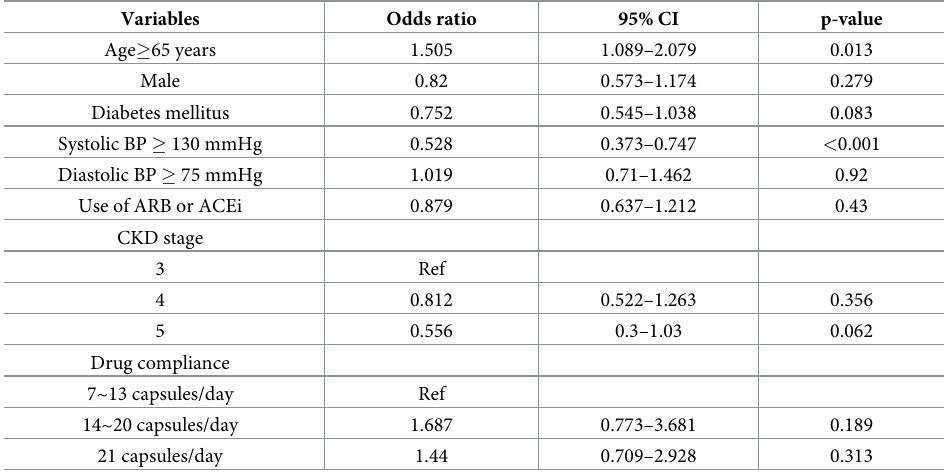
Table 3. Multivariate logistic regression analysis for renal function preservation ( Δ eGFR � 0).